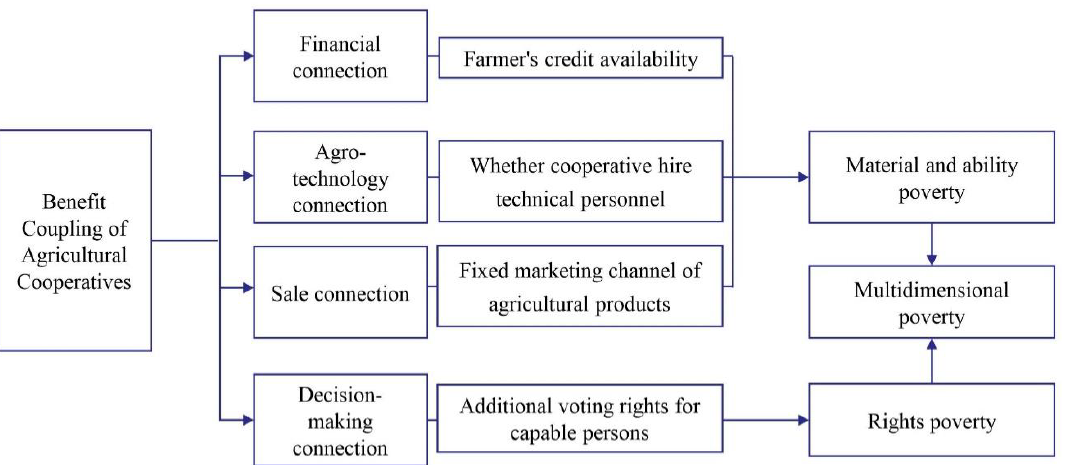
Figure 1. Schematic diagram of benefit coupling mechanism and multi-dimensional poverty mitigation by agricultural cooperatives.